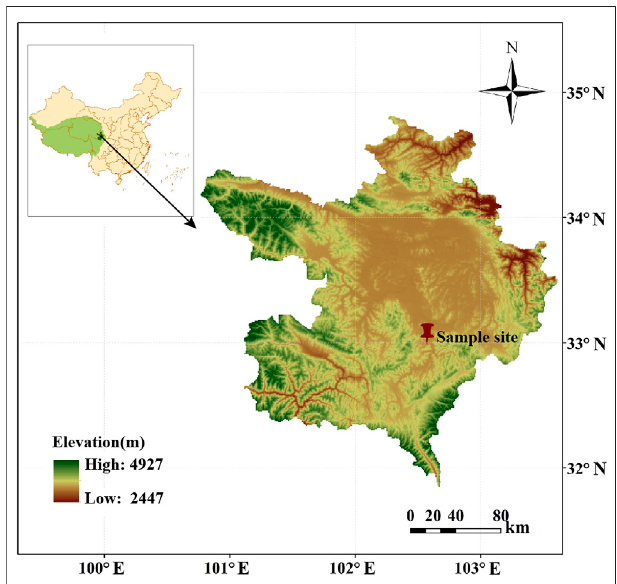
FIGURE 1| Map ofthe Zoîgé Plateau with the sample site location in the Ruokeba peatland. The green part of China map is